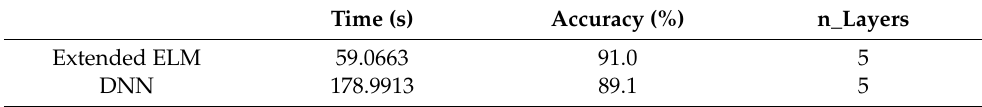
Table 4. Time consumed by different